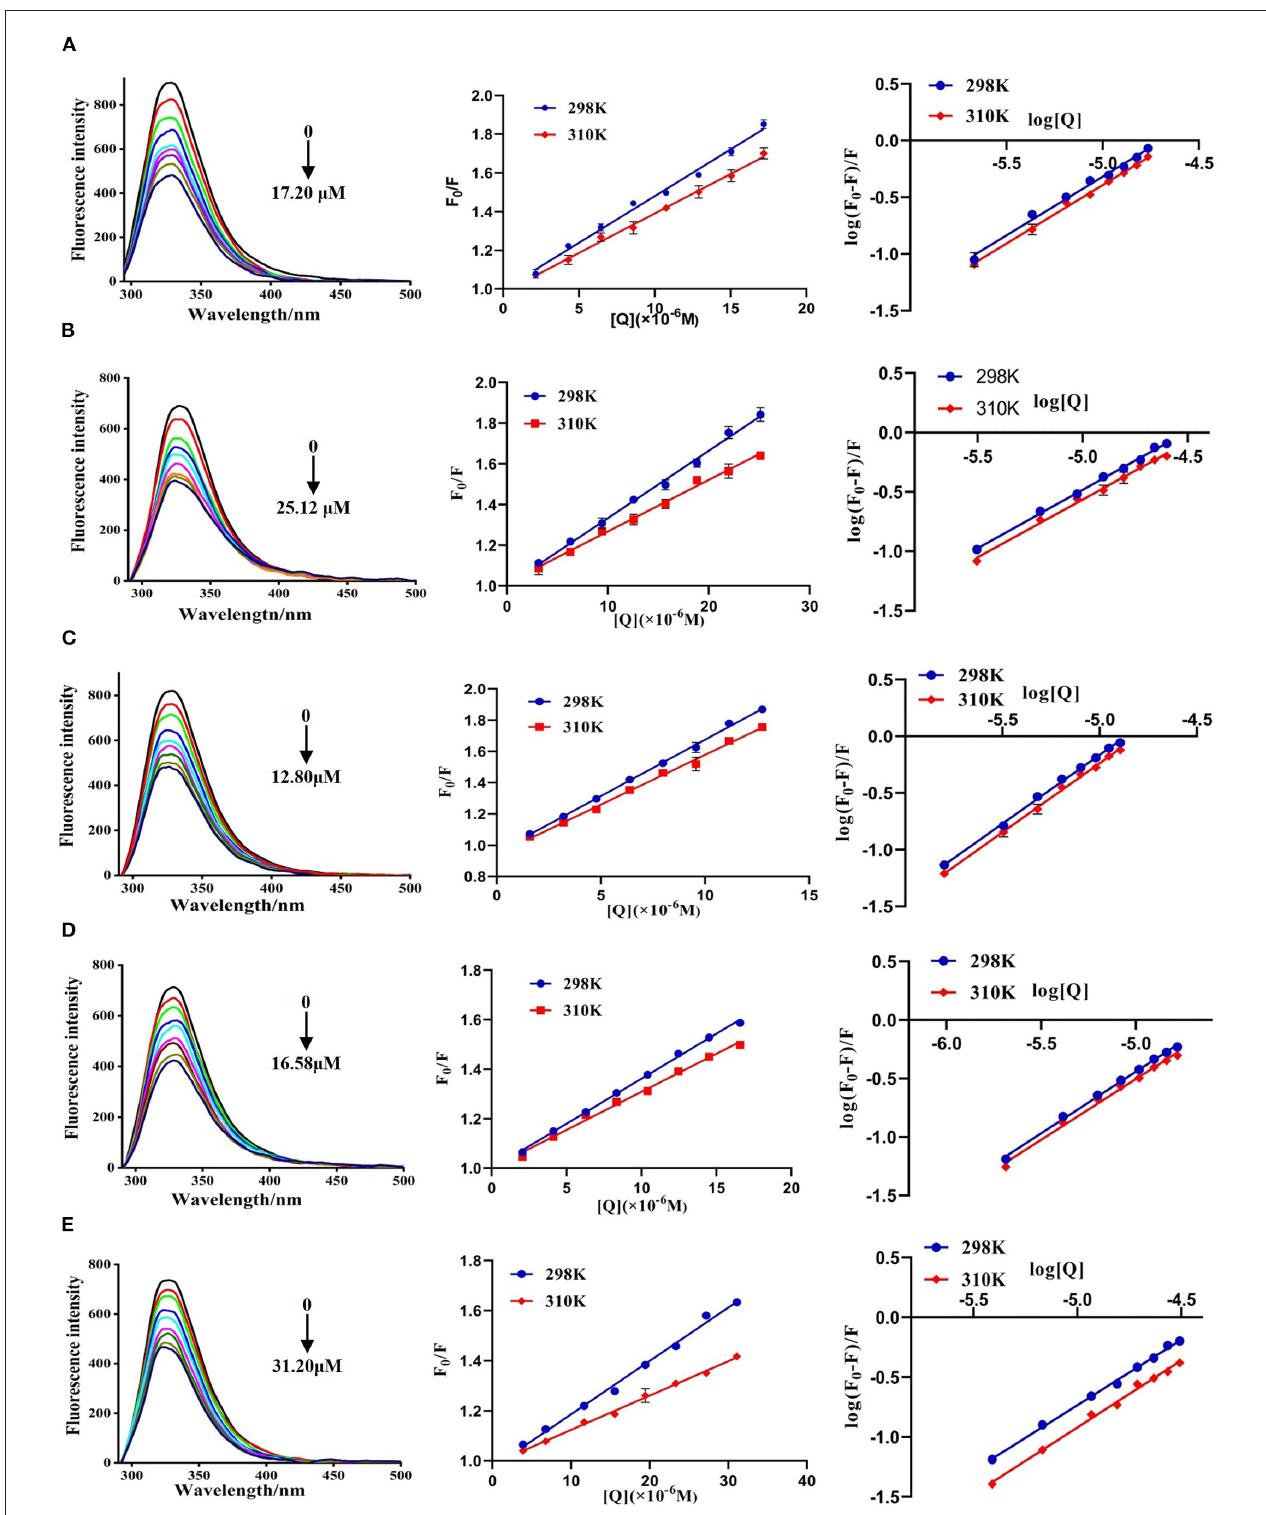
FIGURE 4 | Fluorescence spectra of DPP-4 in the absence and presence of hyperoside (A) , myricetin (B) , narcissoside (C) , cyanidin 3-O-glucoside (D) , isoliquiritigenin (E) at different concentrations and the Stern-Volmer plots for the fluorescence quenching of DPP-4 by the flavonoids at different temperatures.